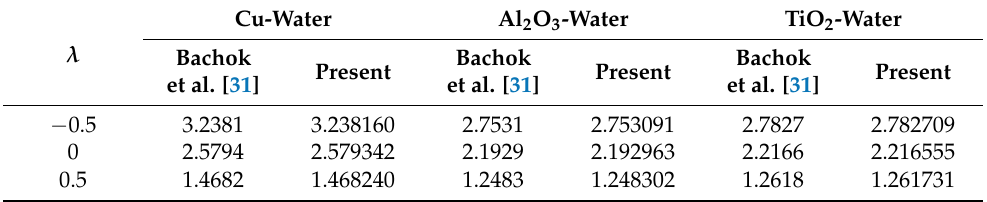
Table 4. Comparison values of Nu x Re − 1/2 x for some values of λ when ϕ 1 = 0.1, ϕ 2 = 0 and β =